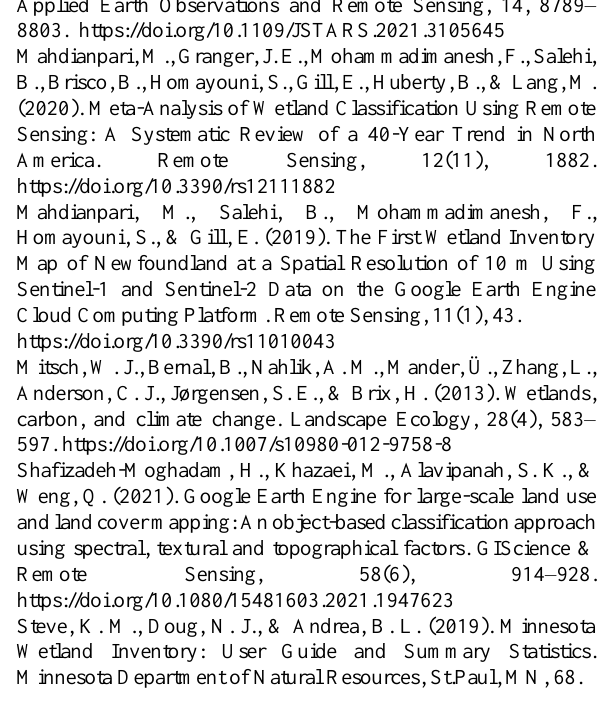
Figure 5. Output classification of random